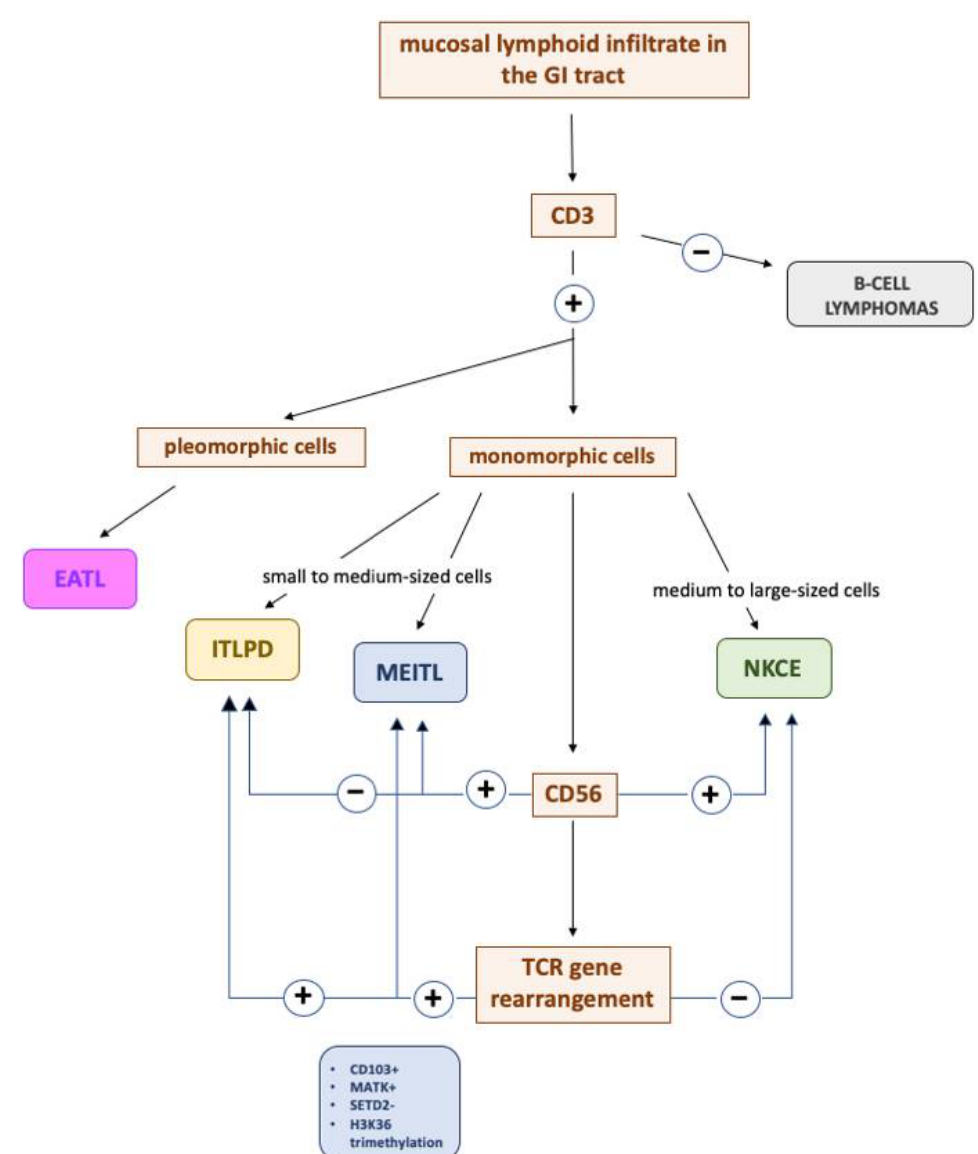
Figure 4. Essential diagnostic algorithm to discriminate iTLPD-GI from its closest